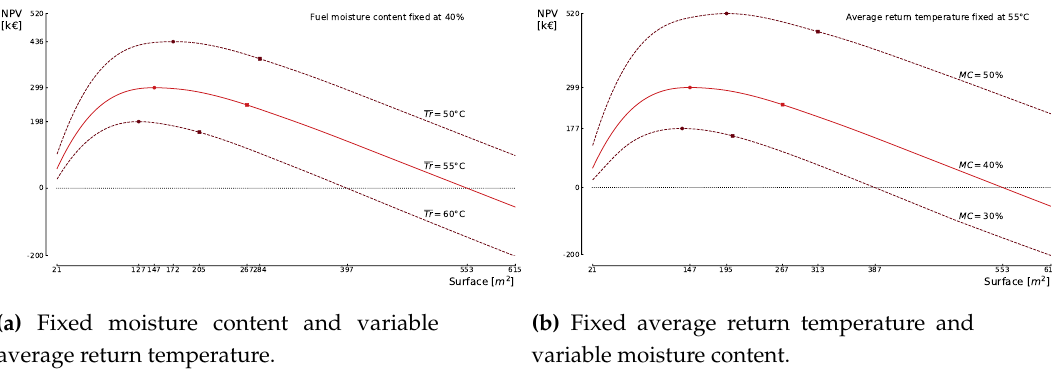
average return temperature. Figure 9. Net Present Value (NPV) as a function of the FGC surface for ( a ) various return temperatures and ( b ) various fuel moisture contents.